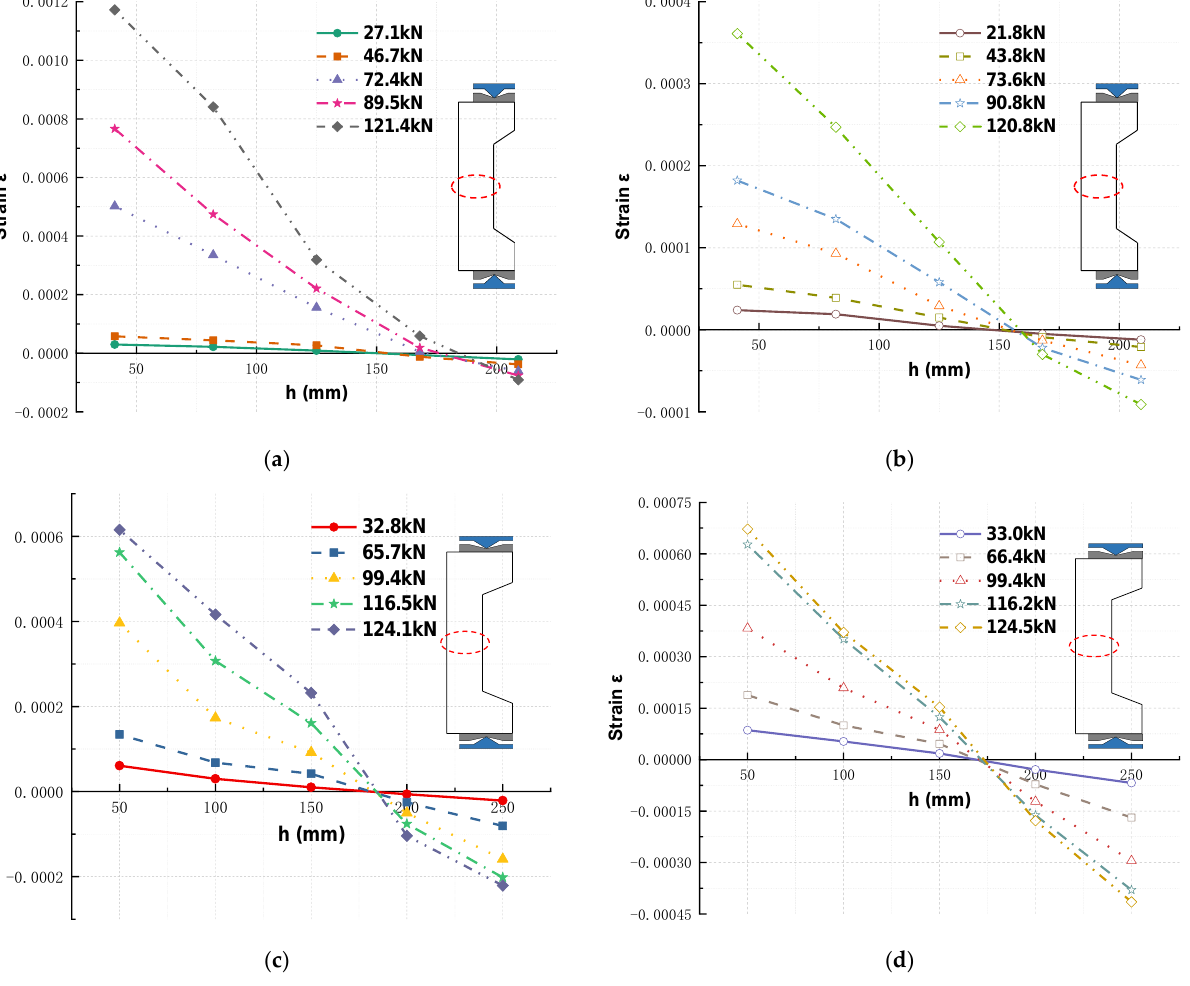
Figure 14. Typical concrete strain distribution along the section depth at the mid-span point: ( a ) FITRC45-2 column specimen; ( b ) CRC45 column specimen; ( c ) FITRC35-2 column specimen; ( d ) CRC35 column specimen.